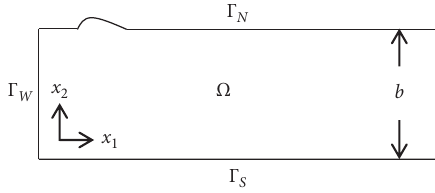
Figure 1: The illustration of domain Ω . Figure